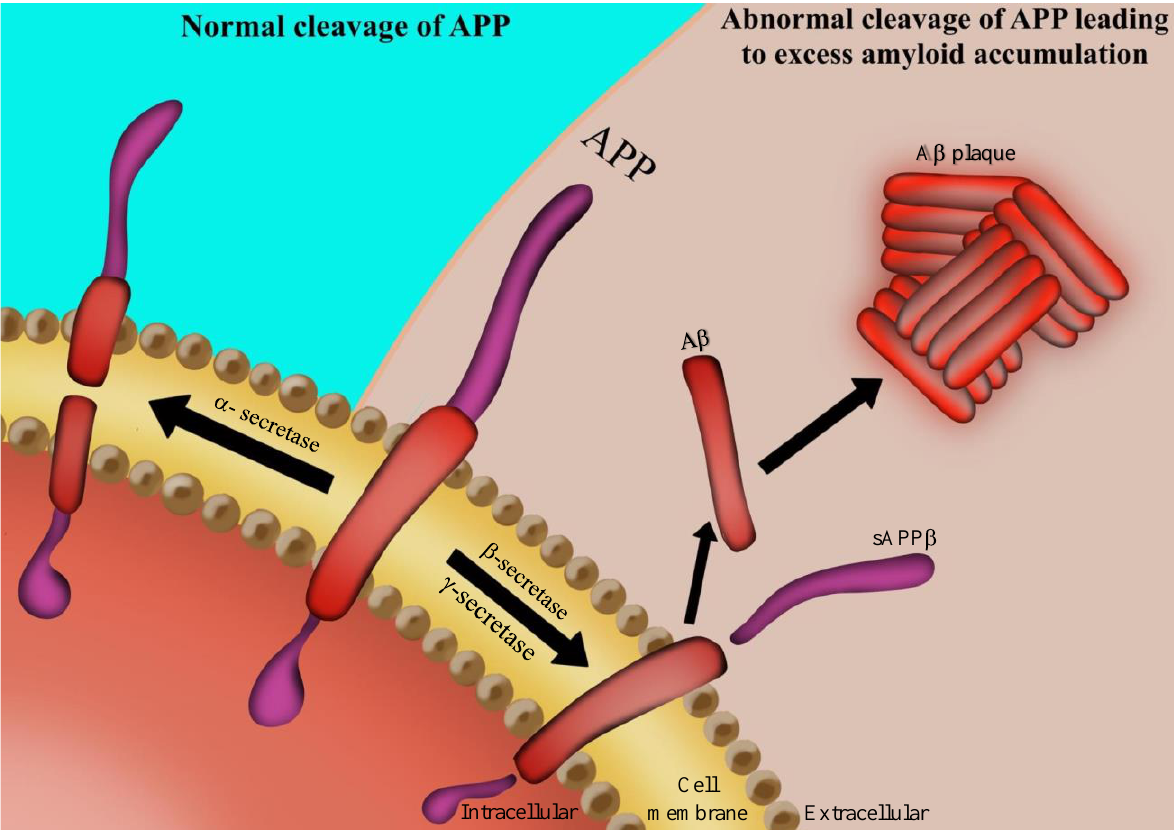
Figure 1. Aβ formation: the amyloid precursor protein (APP) is a transmembrane protein of the neuronal cell. In the case when it is cleaved by α-secretase, the formed soluble aggregates can be digested by microglial cells. When APP is cleaved by β-secretase and γ-secretase, it leads to formation of Aβ insoluble aggregates. Such protein aggregation results in amyloid plaques, one of the hallmarks of AD.